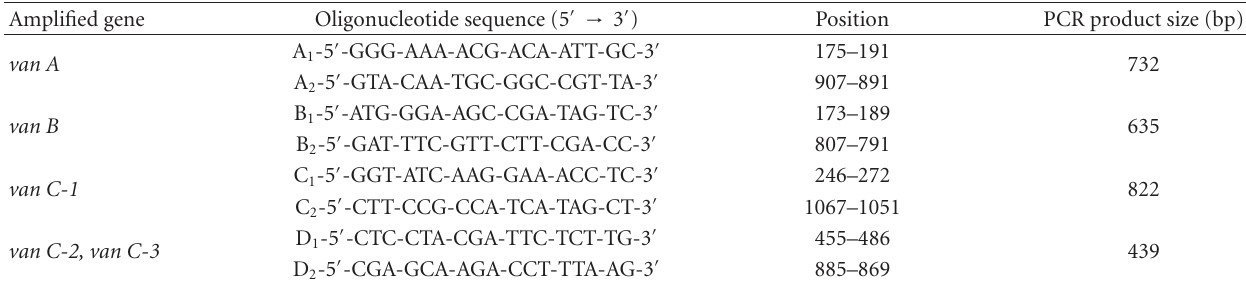
Table 2: Oligonucleotide primers used to amplify van genes.